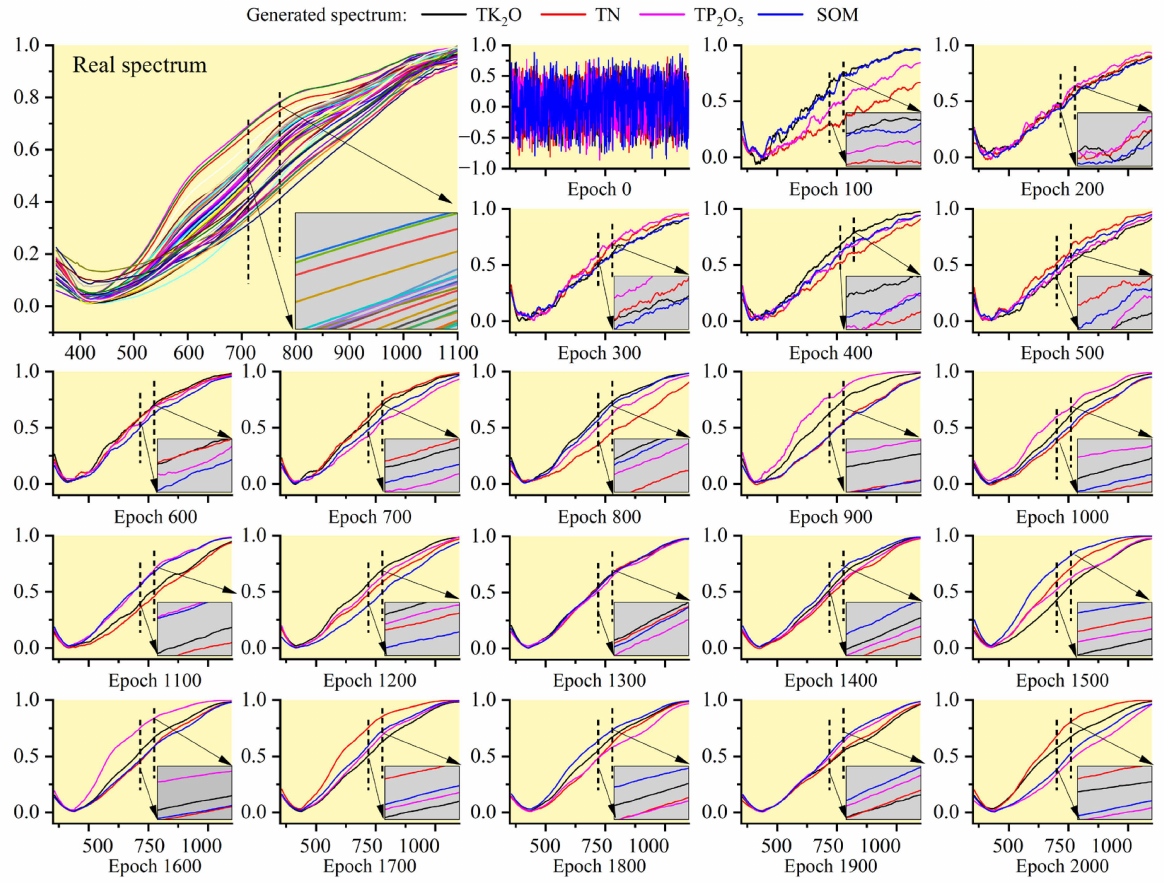
Figure 5. Comparison of original spectra and GAN-generated spectra in different